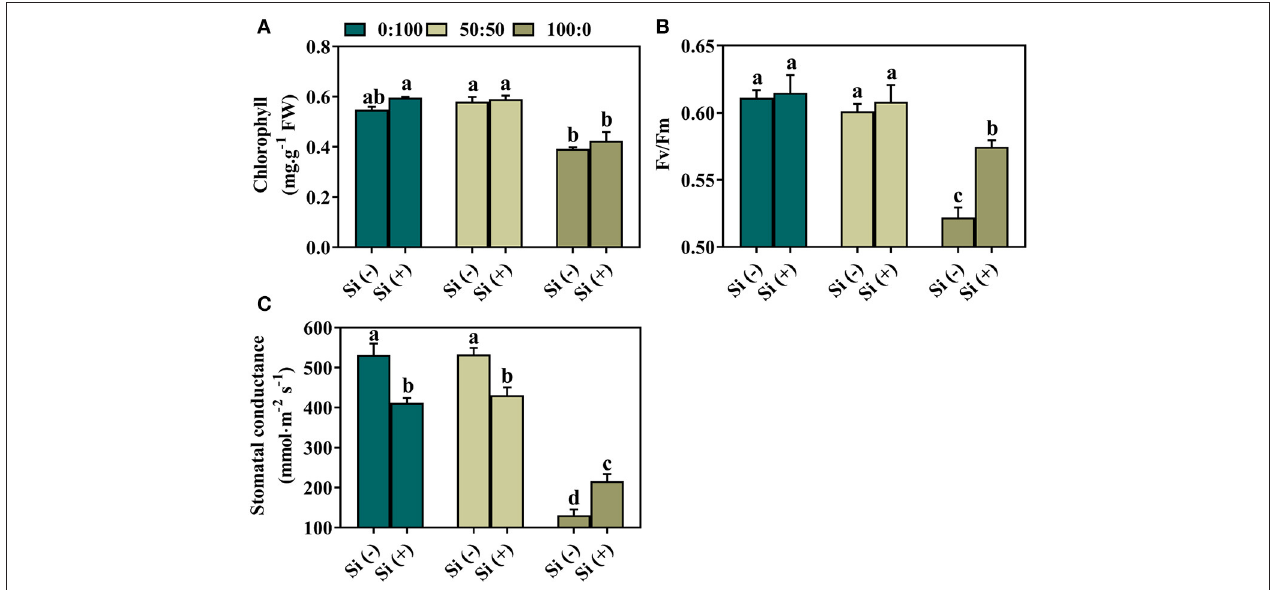
FIGURE 5 | The responses of photosynthesis-related parameters regarding the (A) chlorophyll content, (B) Fv/Fm (quantum efficiency), and (C) stomatal conductance to three NH + 4 :NO − 3 ratios in the absence and presence of Si. Data are the average of n = 6 independent replicates ± standard deviation (SD); different lowercases indicate significant differences at p < 0.05 level according to Duncan’s multiple range